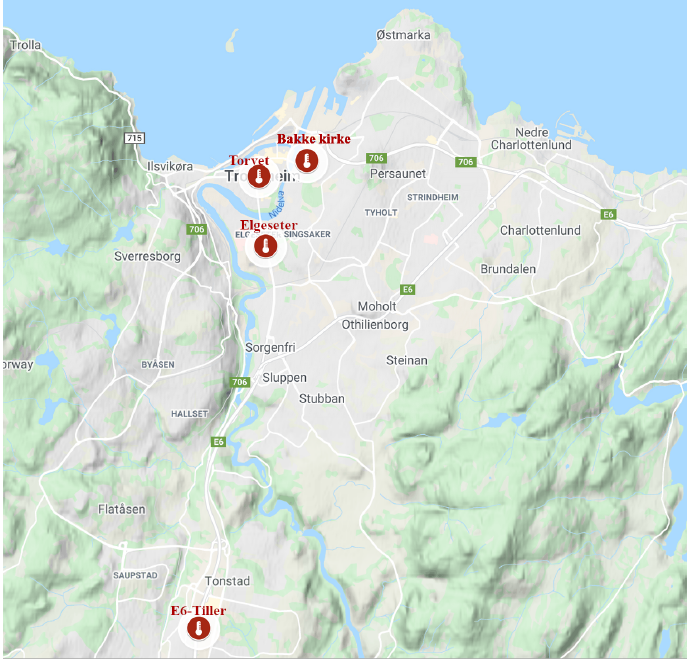
Figure 2. Air quality monitoring stations in Trondheim, Norway.